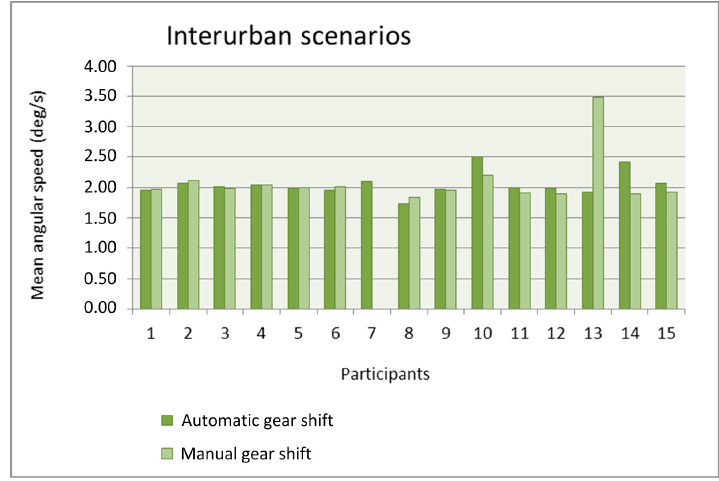
Figure 13. Mean angular speed as a function of the gear shift type in the interurban scenarios.